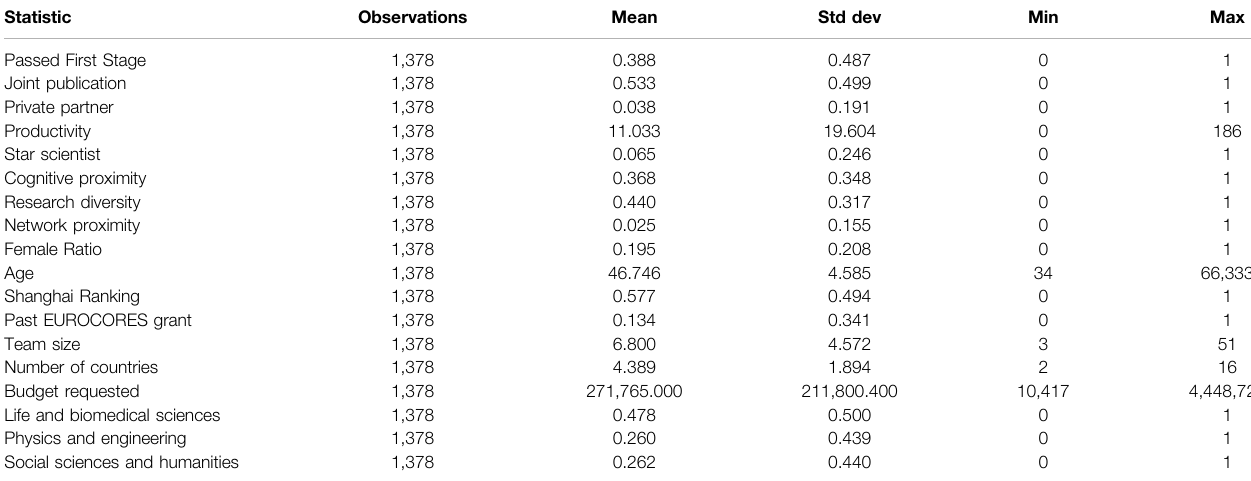
TABLE 2 | Descriptive statistics of applicants — First stage. Statistic